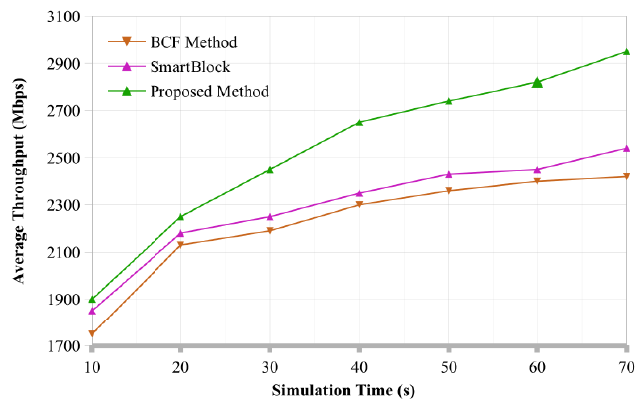
Figure 6. Throughput analysis of proposed system compared with existing methods.